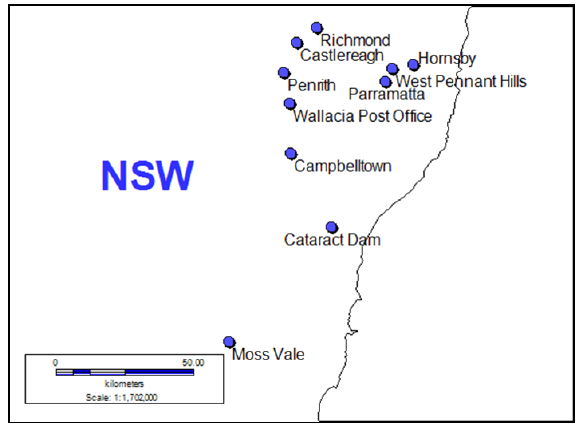
Figure 1. Ten selected locations in the Greater Sydney regions.